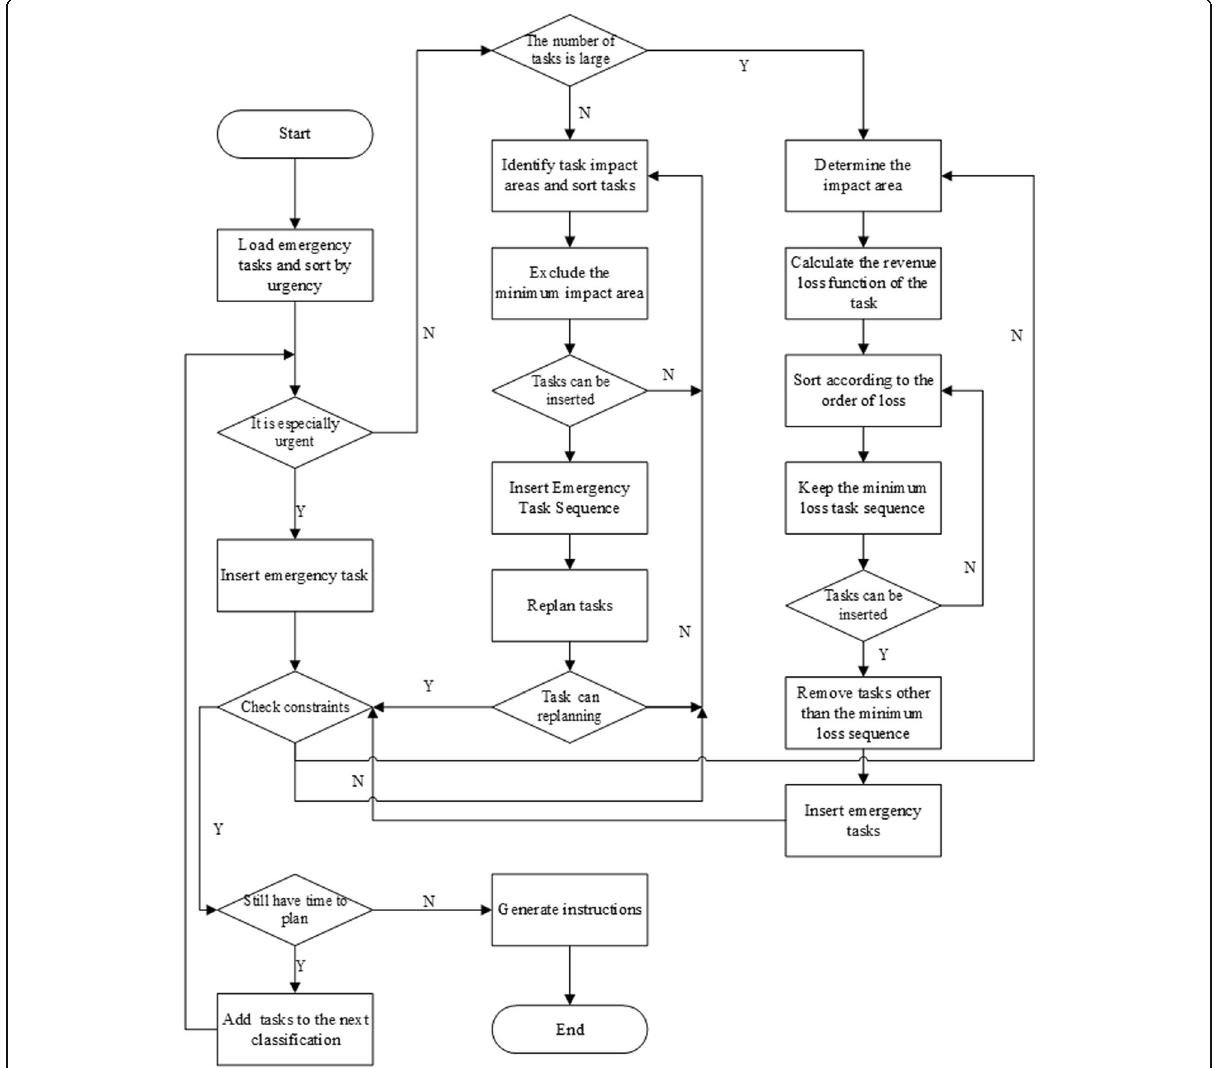
Fig. 2 The overall flow of the